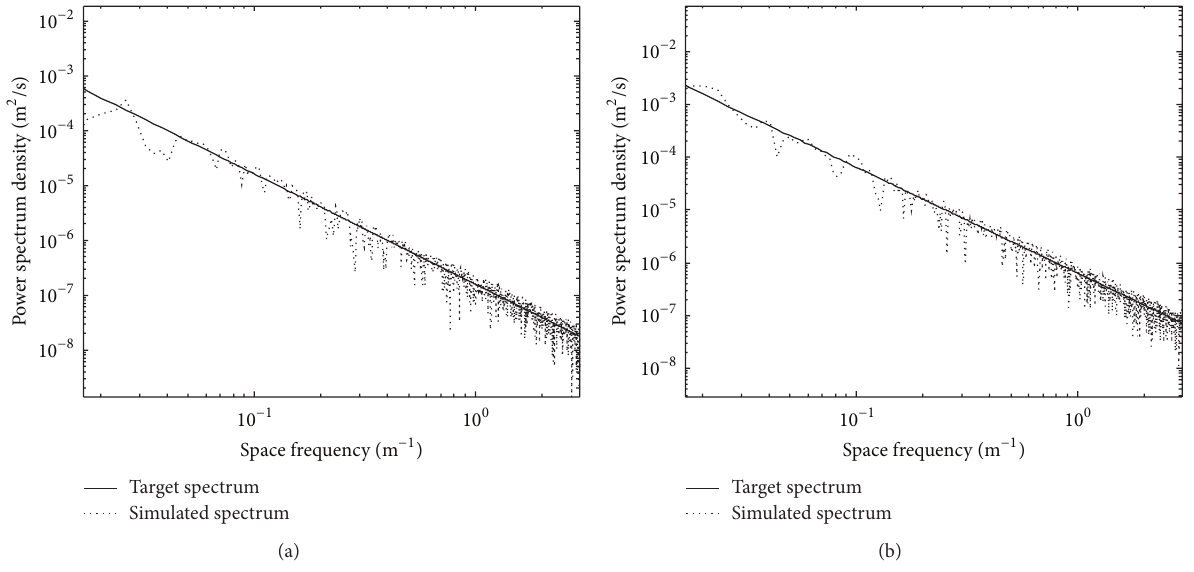
Figure 6: The power spectrum densities of surface roughness: grade of roughness: (a) good; (b)